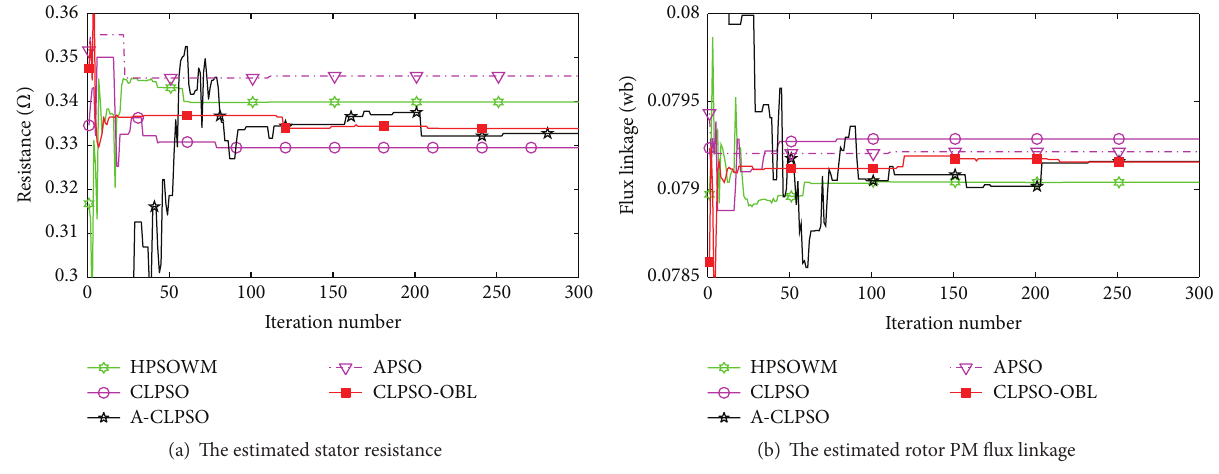
Figure 5: The curve of estimated parameters with normal temperature.